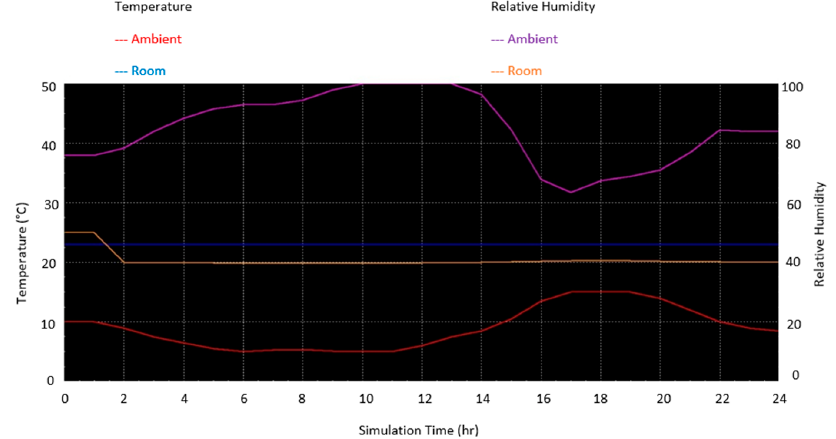
Figure 19. TRNSYS layout for option C.